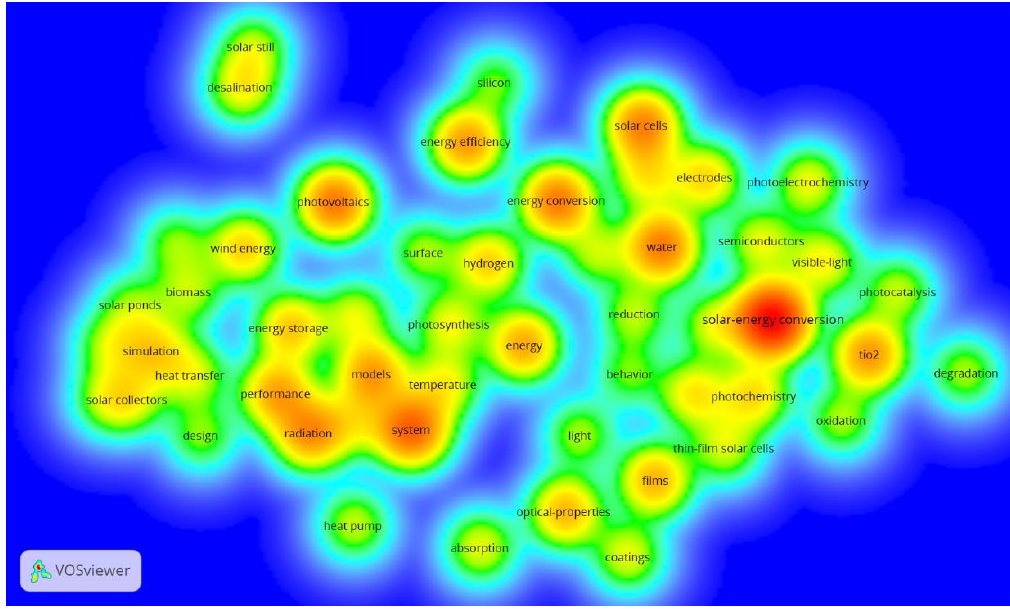
Figure 12. Hot topics in Solar Energy research between 1990–1999 (1% most common keywords). Based on the fewer keywords, hot areas appear isolated, but a higher relevance on solar-energy conversion topics can be appreciated, as well as in photovoltaics, titanium